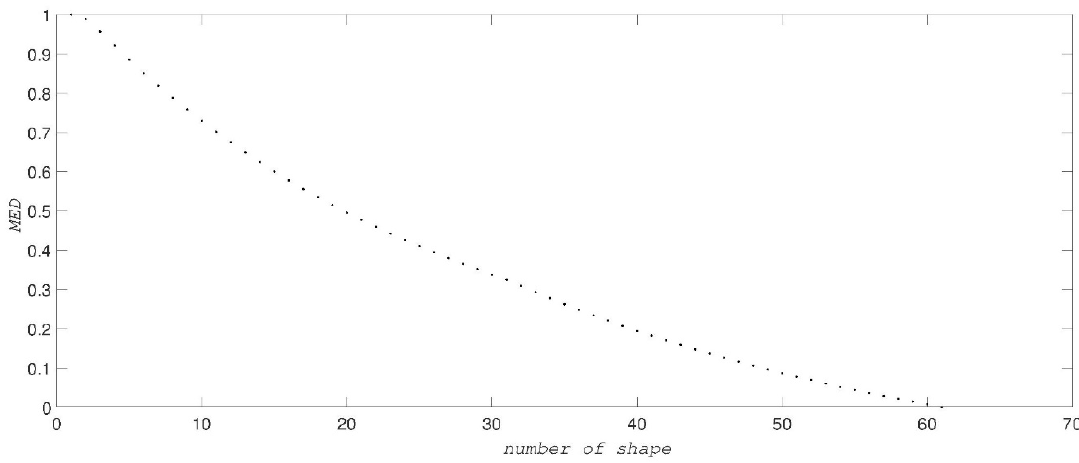
Figure 2. The MED values for the simple shape dataset. The abscissa gives the number of test shapes. Table 1. The names of the different conformations of peptides generated by MOE software and the corresponding values of their MED. Larger numbers correspond to a more closed (longer) peptide